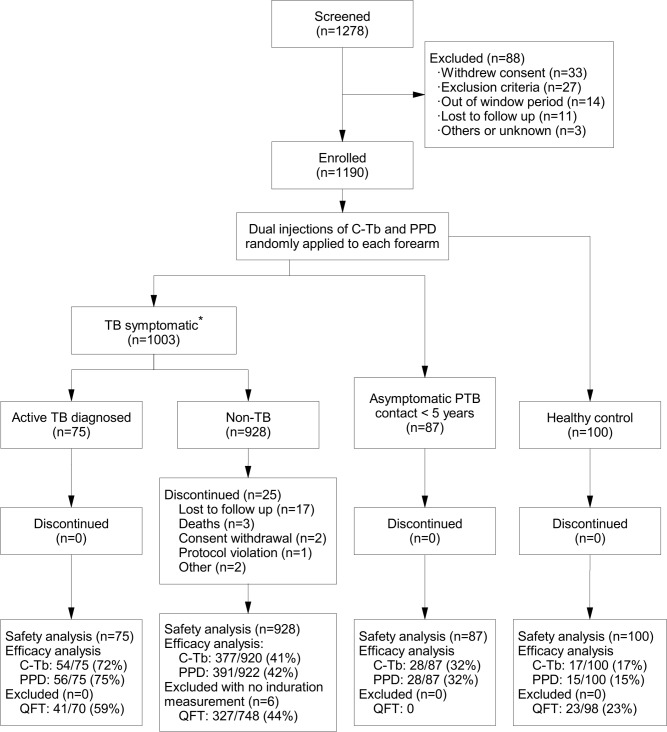
Overview of the trial participants.*These were clinic attendees that on follow-up segregated into those with microbiologically confirmed active TB and non-TB participants. Efficacy data are presented as number of test positives/n (%).